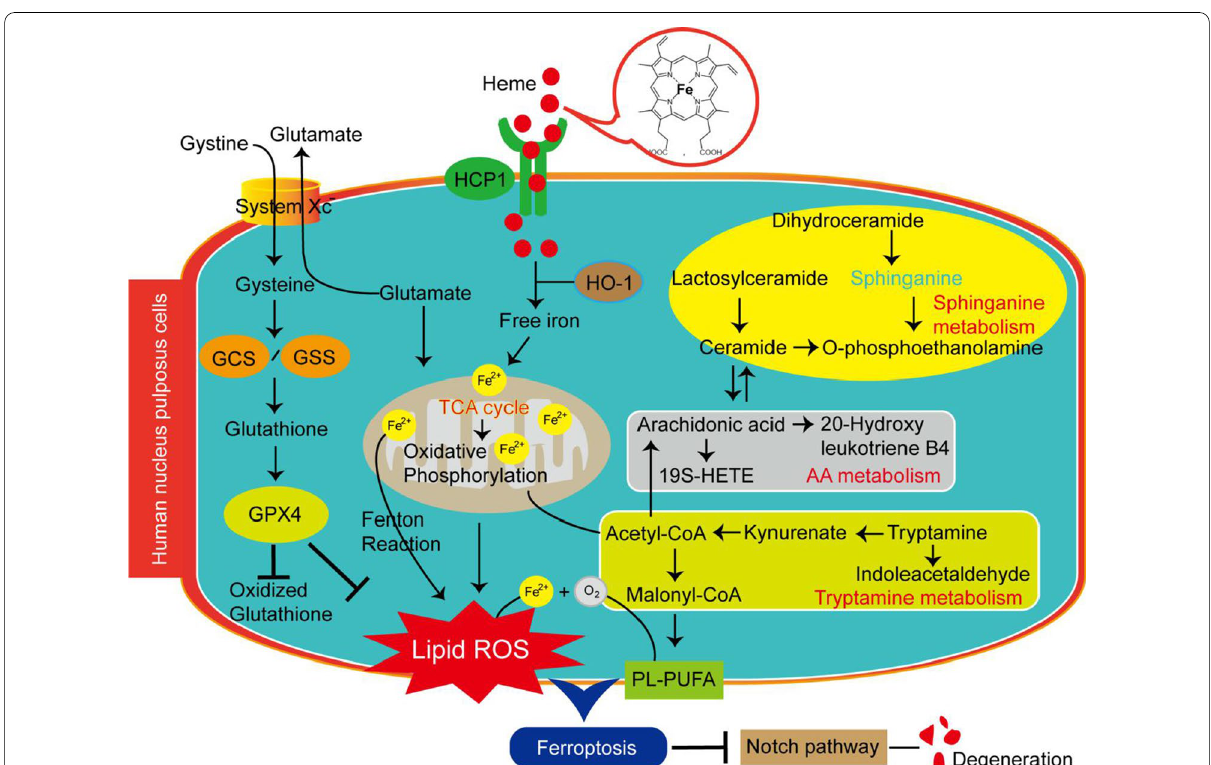
Fig. 8 A potential mechanism by which heme iron induces ferroptosis and degeneration of human nucleus pulposus cells. Heme enters the cell through carrier proteins and is degraded by HO-1. This process releases free ferrous ions. Excessive free ferrous iron is oxidized to trivalent iron through the Fenton reaction in the presence of hydrogen peroxide that is metabolized by the cell, forming dangerous hydroxyl free radicals, which lead to lipid peroxidation and ferroptosis (middle). The substrates of peroxidation are polyunsaturated fatty acids (PL-PUFAs), and the GPX4-glutathione axis can eliminate peroxidized PL-PUFA-OOH (left). The MALDI-TOF MS analysis clearly shows the ferroptosis-related metabolic network, which involves sphingolipid metabolism, the tricarboxylic acid (TCA) cycle, arachidonic acid (AA) metabolism, and tryptamine metabolism-related molecules